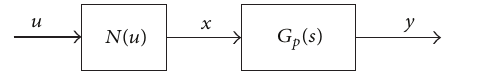
Figure 2: Hammerstein structure of heat exchanger model.